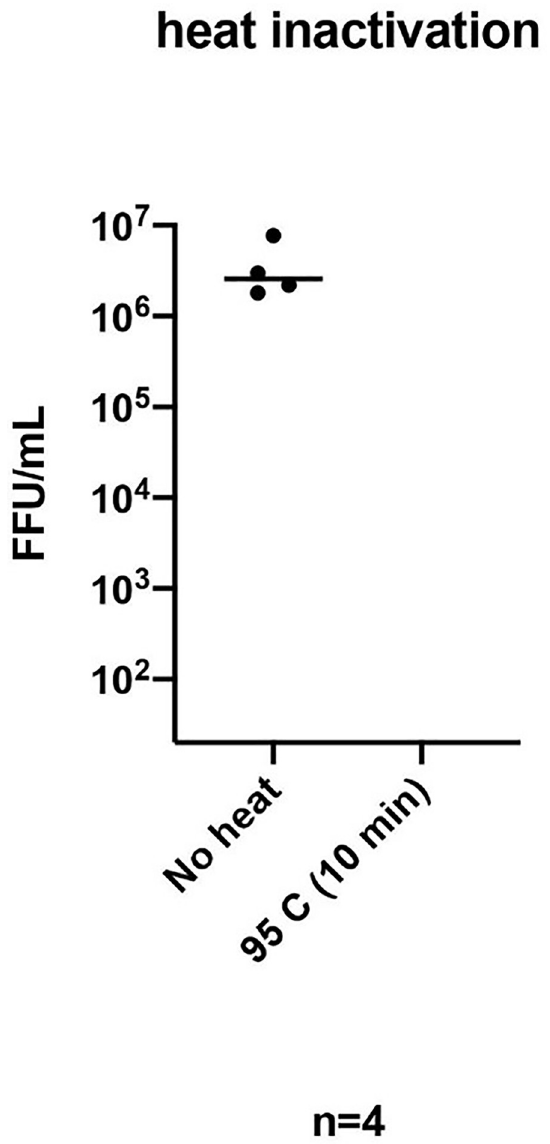
Fig 2. Heat treatment inactivates SARS-CoV-2. Stocks of SARS-CoV-2 split into aliquots were treated at 95˚C for 10 min or untreated. Viral titer was determined using a focus forming assay with an antibody recognizing the viral N protein. Measurements are in focus forming units (FFU) per milliliter ( n = 4 replicates). The limit of detection for this assay was 20 FFU/ml.